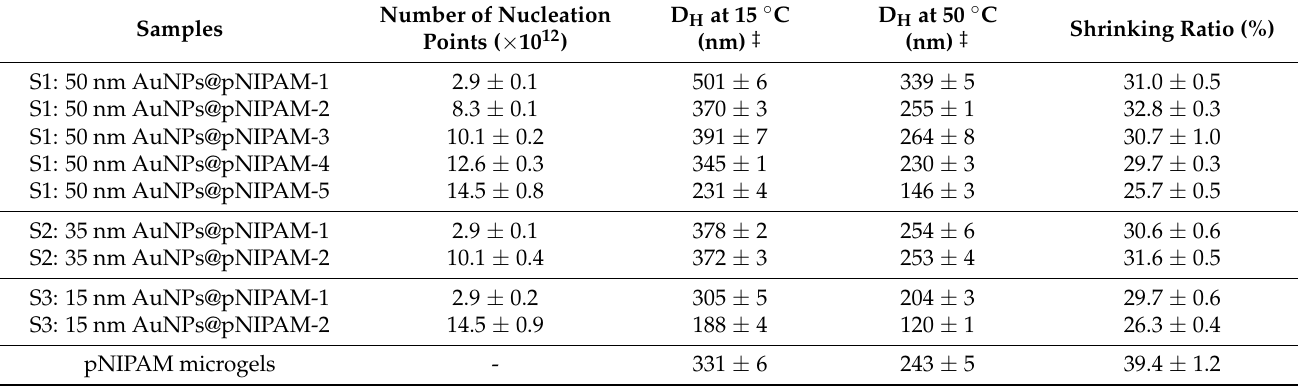
Table 2. Summary of the DLS measurements at 15 and 50 ◦ C and the shrinking ratio of each sample. Samples